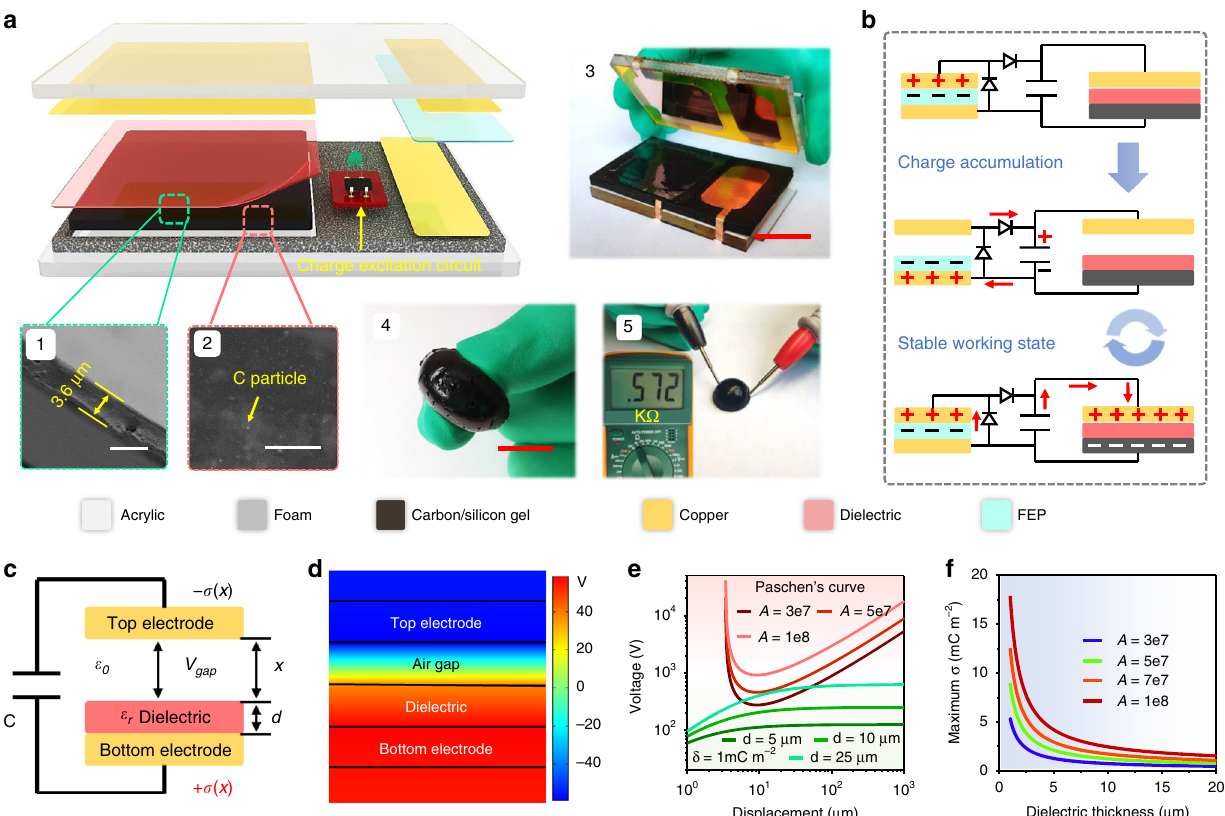
Fig. 1 Working mechanism and maximum charge density. a Structural schematic of charge-excitation triboelectric nanogenerator (CE-TENG). Inset 1 shows cross-section view (SEM) of the dielectric fi lm (scale bar: 5 μ m). Inset 2 is the SEM image of carbon nanoparticle dispersed in silicone matrix (scale bar: 20 μ m). Inset 3 presents the photograph of CE-TENG device (scale bar: 2 cm). Inset 4 is the photograph of carbon gel electrode. Inset 5 demonstrates the conductivity of carbon gel electrode (scale bar: 1 cm). b Basic working mechanism of CE-TENG. c Equivalent physical and electric model of CE-TENG and some critical parameters are also listed in the schematic. d Simulated potential distribution of main TENG under a certain air gap distance using Comsol Multiphysics (electrodes and dielectric thickness: 0.1 mm, air gap: 0.1 mm, dielectric constant: 4.6, σ (0) = 2 × 10 − 3 C/m 2 ). e Giving the theoretical Paschen ’ s curves under different value of A which determined by atmospheric content, and voltage curves between top electrode and dielectric with various dielectric thickness under a certain charge density σ (0) = 1 mC m − 2 . f The maximum charge density limited by air breakdown with different dielectric thickness and atmospheric constant